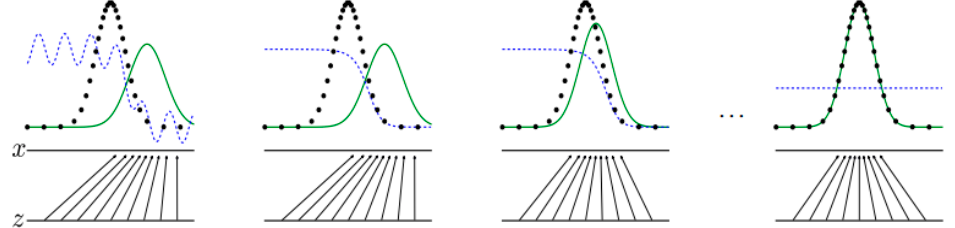
Figure 4. Distribution of discriminator (blue), generator (green) and real data (black) according to the learning process.